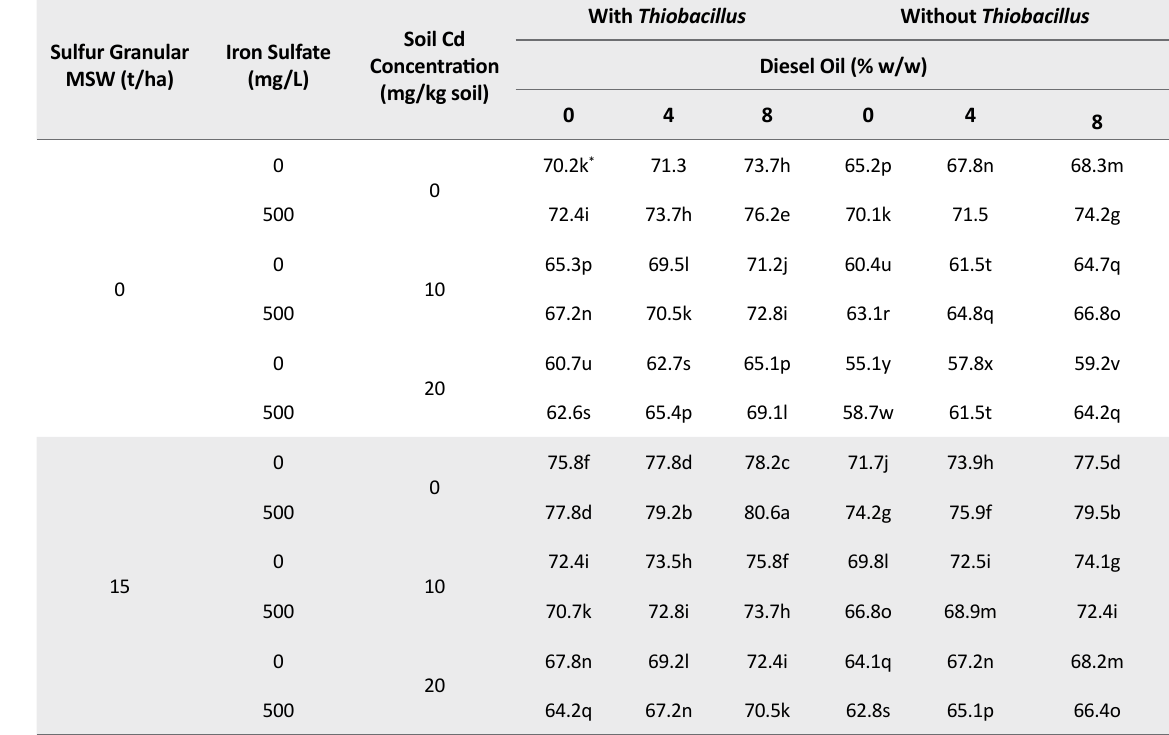
Table 2. Effect of treatments on bio-degradation of diesel oil in the presence of thiobacillus bacteria